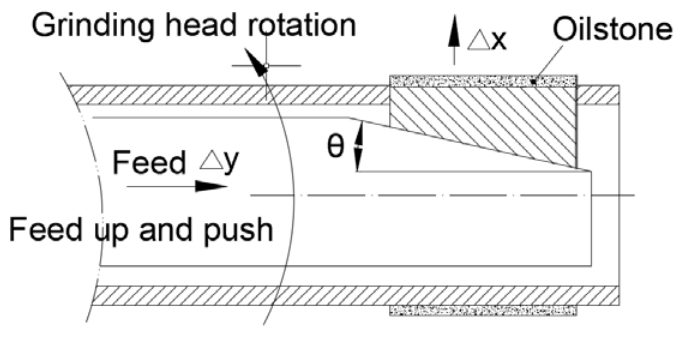
Figure 2. Schematic diagram of honing head structure.